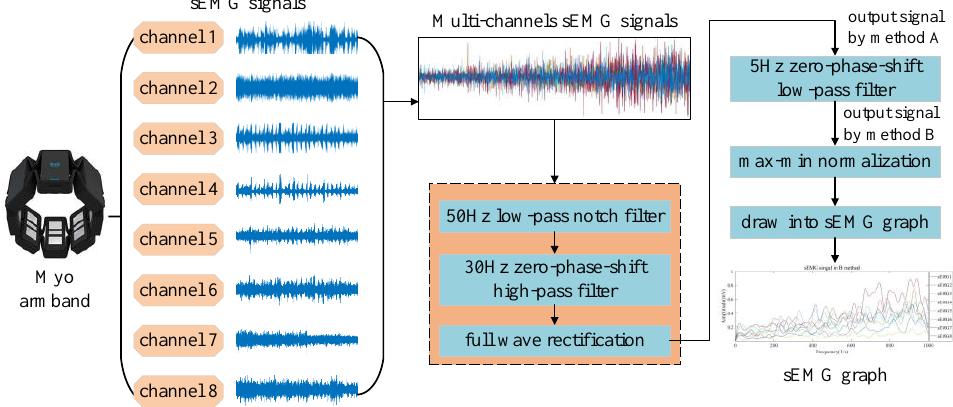
Figure 5. Preprocessing flow of surface electromyography (sEMG) signals.